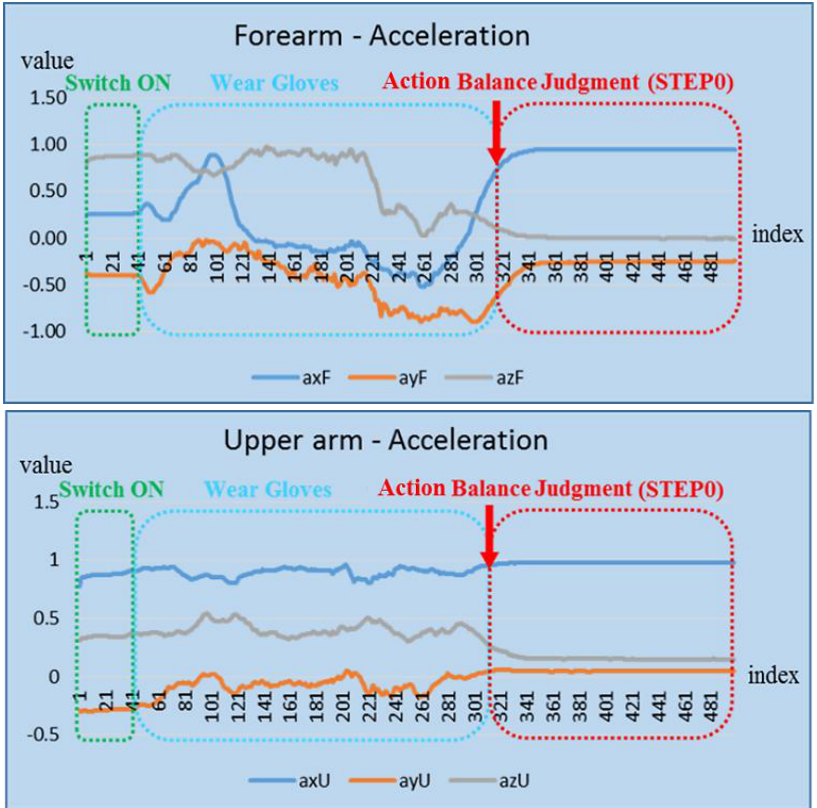
Figure 8. Action balance judgment for getting ready status.